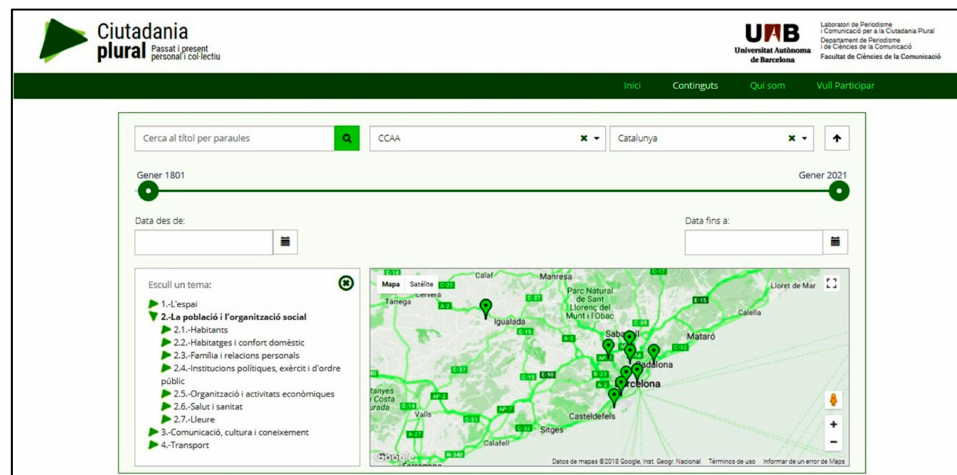
Figure 2. Screenshot of the Ciutadania Plural website (13 May 2021). Selection of the autonomous community of Catalonia (Spain), theme 2: Population and social